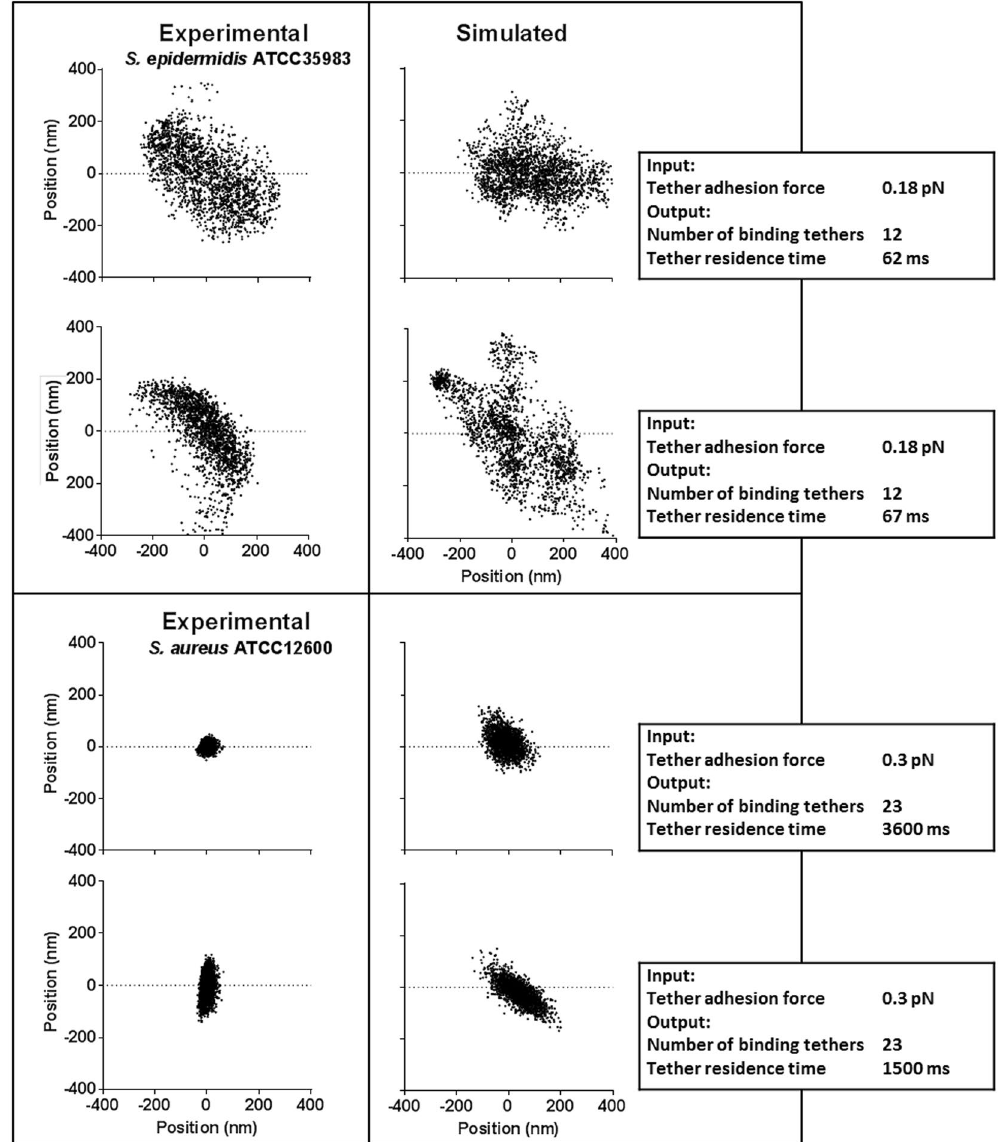
Figure 6. Experimentally observed position-maps of individual bacteria of different strains (left panels), as compared with in silico (right panels) generated position-maps obtained by varying the tether adhesion force and therewith the resulting number of binding tethers per bacterium. Input parameters are listed in Fig. 4B, while the tether adhesion force used in the simulation and the resulting final number of binding tethers are given in the simulated position-maps. For each strain, a circular position-map and an aberrant one is